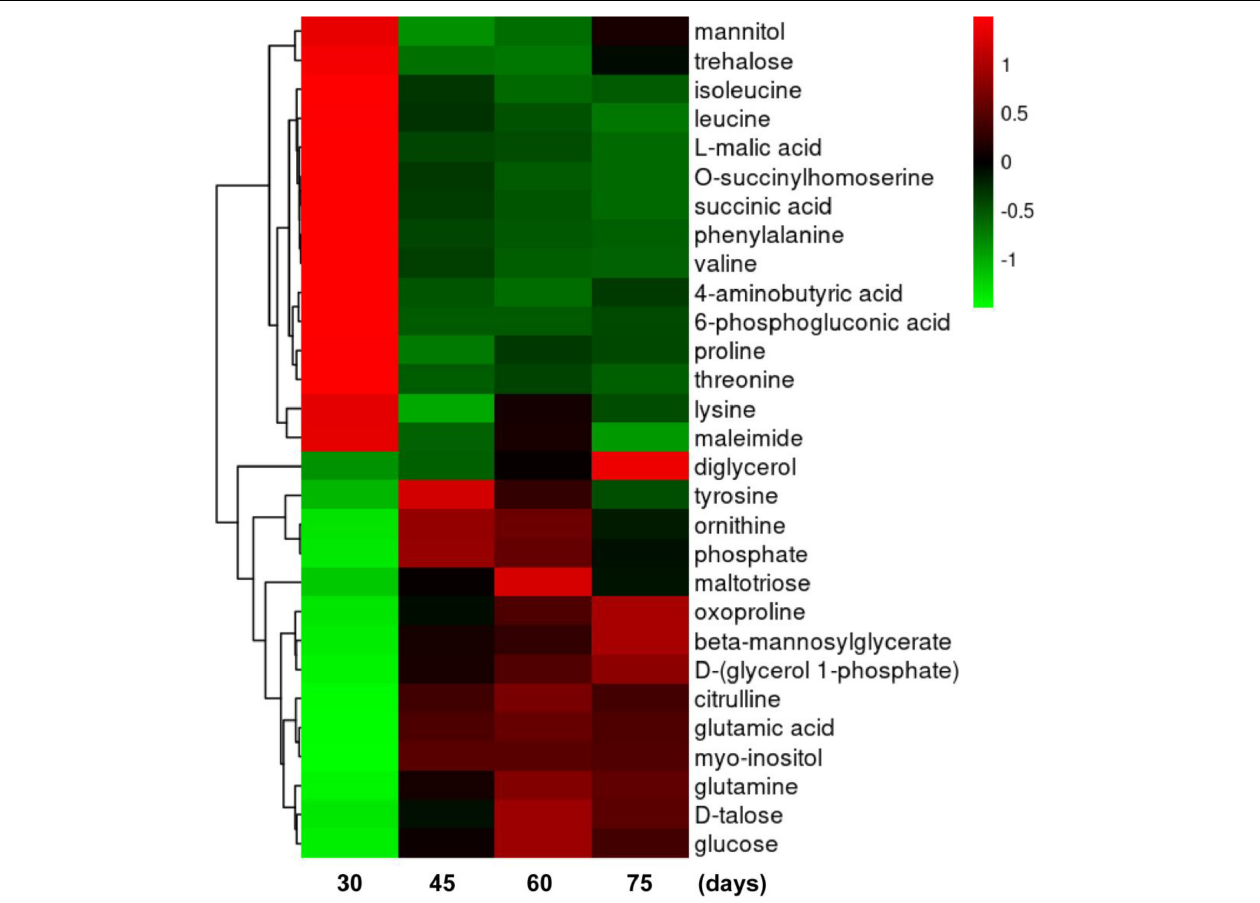
FIGURE 6 | Heat map of clustering analyses of metabolites during brown film formation in Lentinula edodes. Color indicates expression level of a metabolite. The higher the expression level is, the brighter the red; the lower the expression level is, the brighter the green. Each horizontal row represents a metabolite through time (days on the x